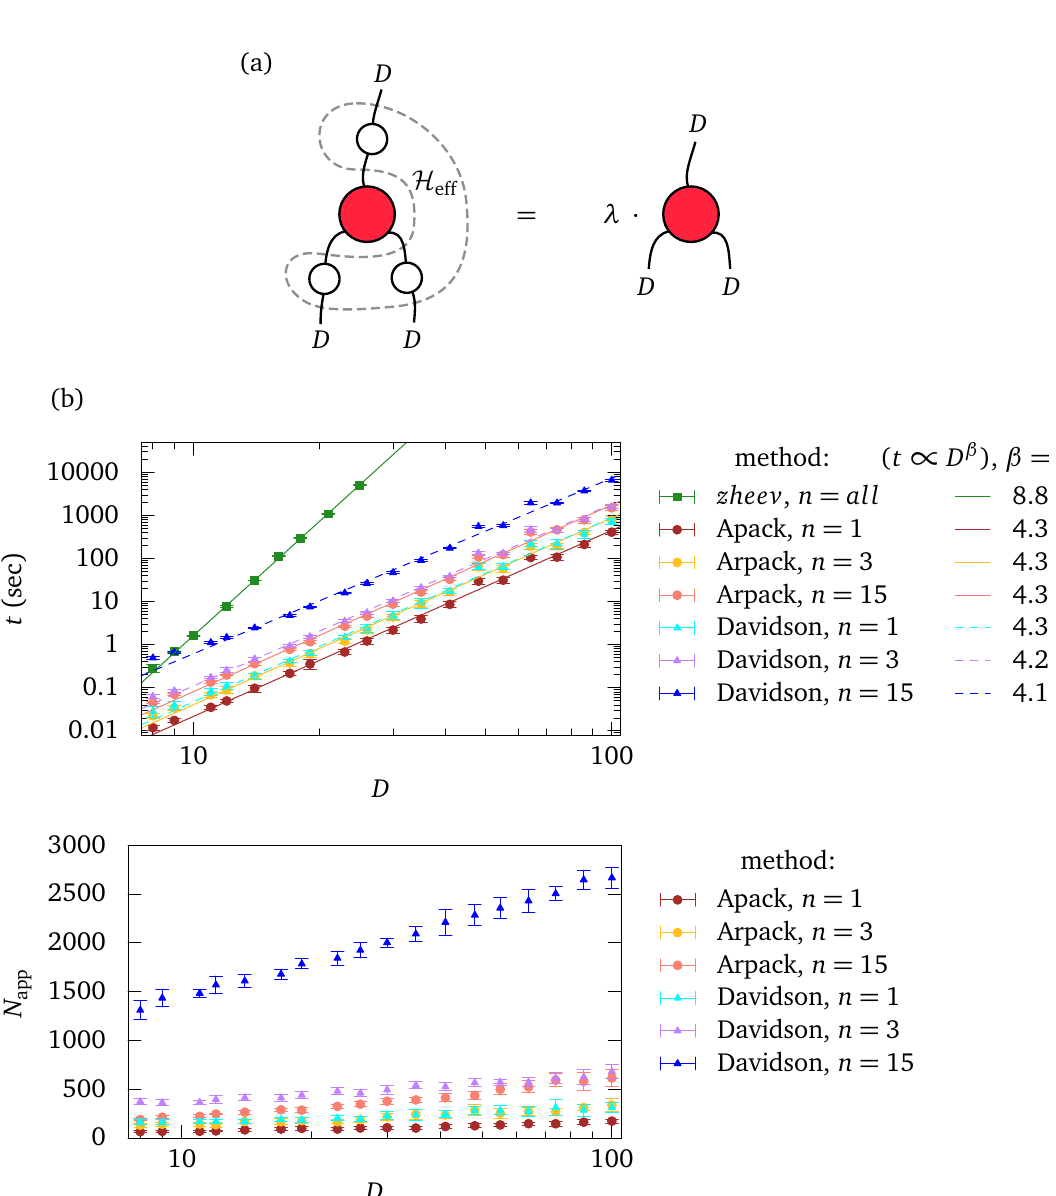
Figure 49: (a) Eigenvalue problem arising in a bTTN single-tensor update scheme. λ is an eigenvalue of the hermitian operator H . (b) Comparison of the performances eff of the diagonalization algorithms listed in Tab. 1. Upper plot: Computation times needed to solve the eigenvalue problem defined in (a), using an effective Hamiltonian with random entries, as a function of the bond dimension D and for different numbers of calculated eigenpairs n . Computation times are averaged over 50 runs, with the error bars indicating the standard deviation. Lower plot: Corresponding number of operator applications N . Note how N only increases weakly (not faster than app app logarithmically) with the problem size (given that the algorithm parameters are properly